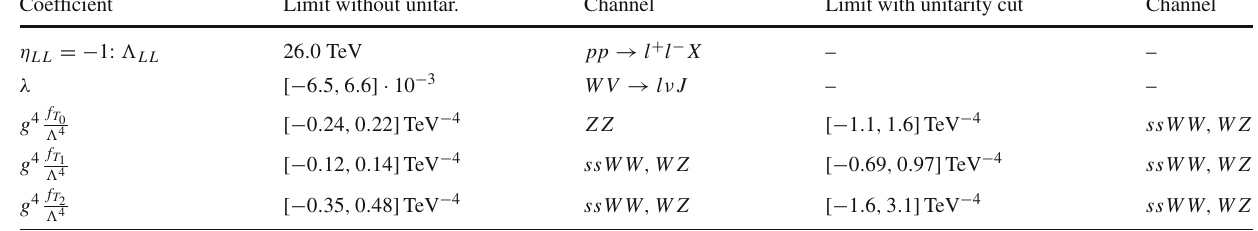
Table1 Experimental95%CLboundsonfour-fermioncouplings[43], aTGCs [45] and aQGCs [46,47]. The values for aQGCs from the CMS analyses are derived from leptonic decay channels in VBS processes only. aQGC bounds are presented with and without a unitarization in Coefficient Limit without unitar. Channel Limit with unitarity cut Channel